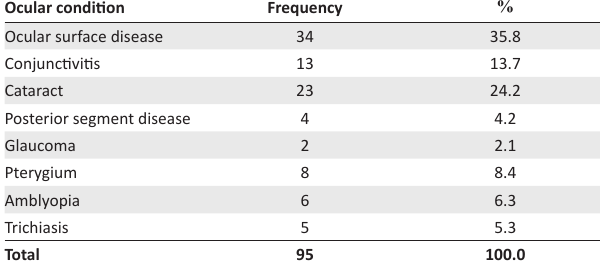
TABLE 4: Ocular presentation amongst the study